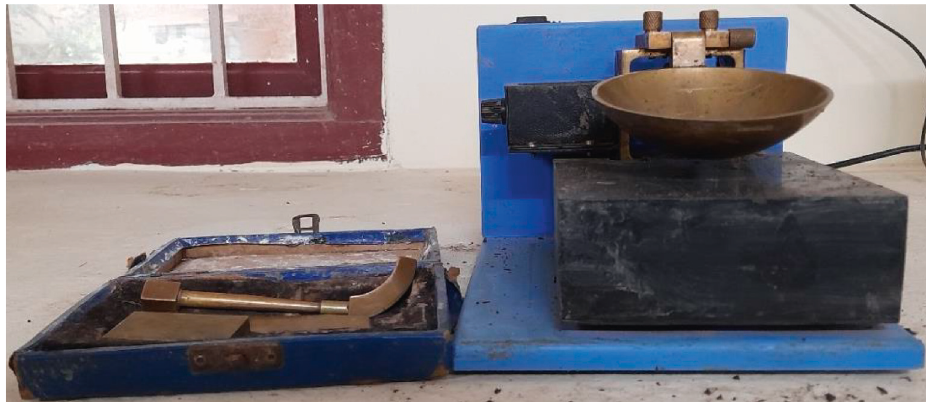
Figure 2: Casagrande cup for performing Atterberg limits.